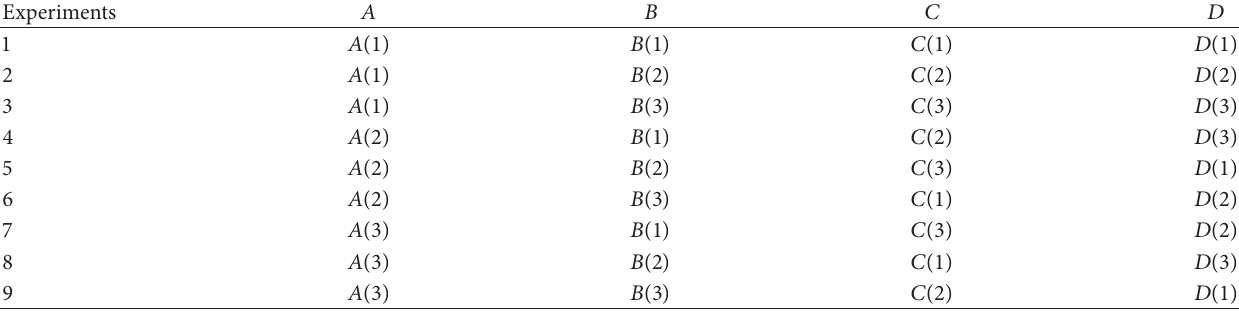
Table 3: Orthogonal array 𝐿9 .